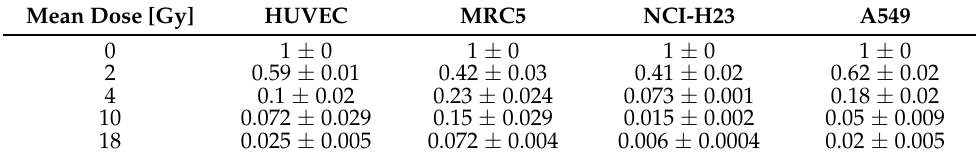
Table A3. Mixed broad beam cell survival data for the four cell lines used. Mean values and standard deviations of three independent repeat experiments are